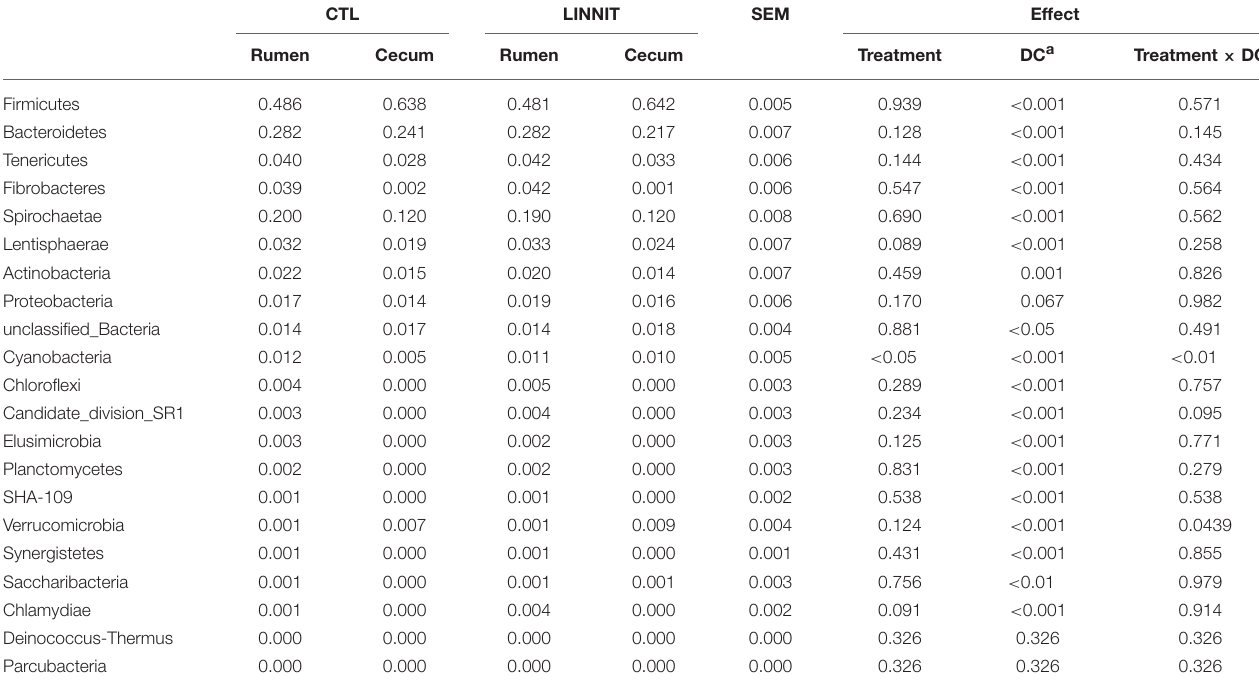
TABLE 6 | Phylum-level taxonomic composition of the ruminal and cecal bacterial communities in bulls receiving a control (CTL) or linseed plus nitrate (LINNIT) supplemented diet. CTL LINNIT SEM